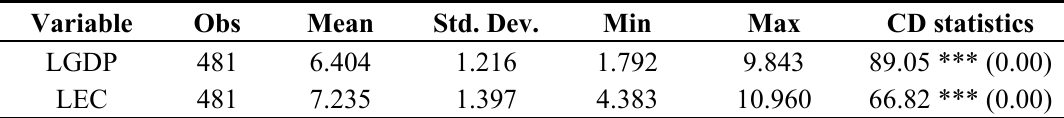
Table 2. Descriptive statistics and cross-sectional dependence (CD)